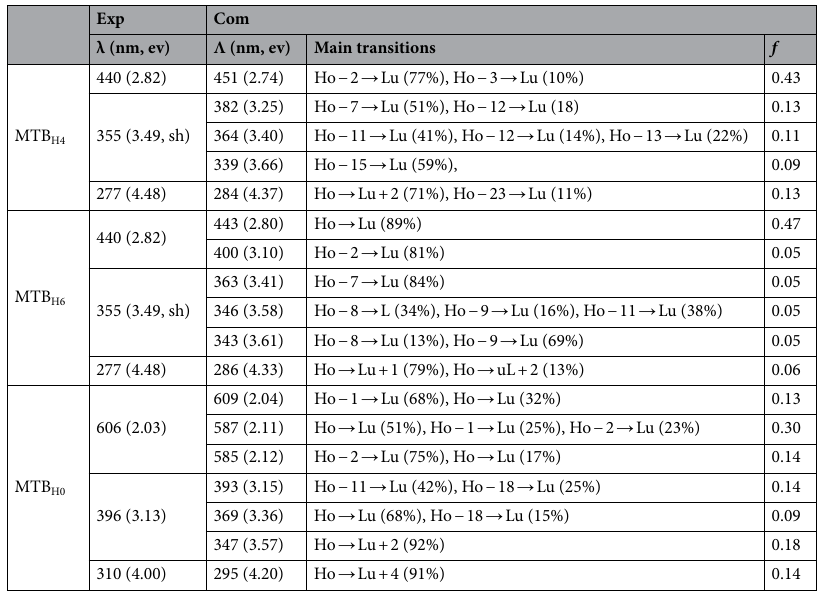
Table 2. Experimental and computed wavelengths, MO contributions (≥ %10), and oscillator strength ( f ) involved in each transition for MTB H4 , MTB H6 , and MTB H0 . Phrase sh stands for